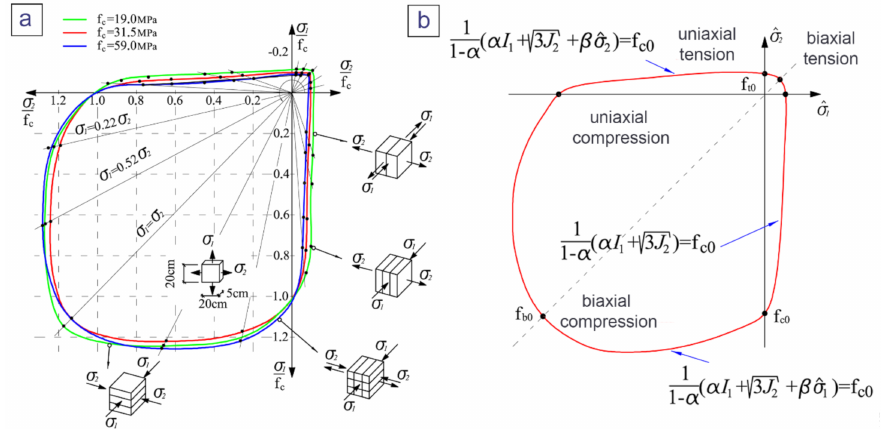
Figure 6. Biaxial strength of concrete according to [23] ( a ) and Lubliner [22] yield function in plane stress space ( b